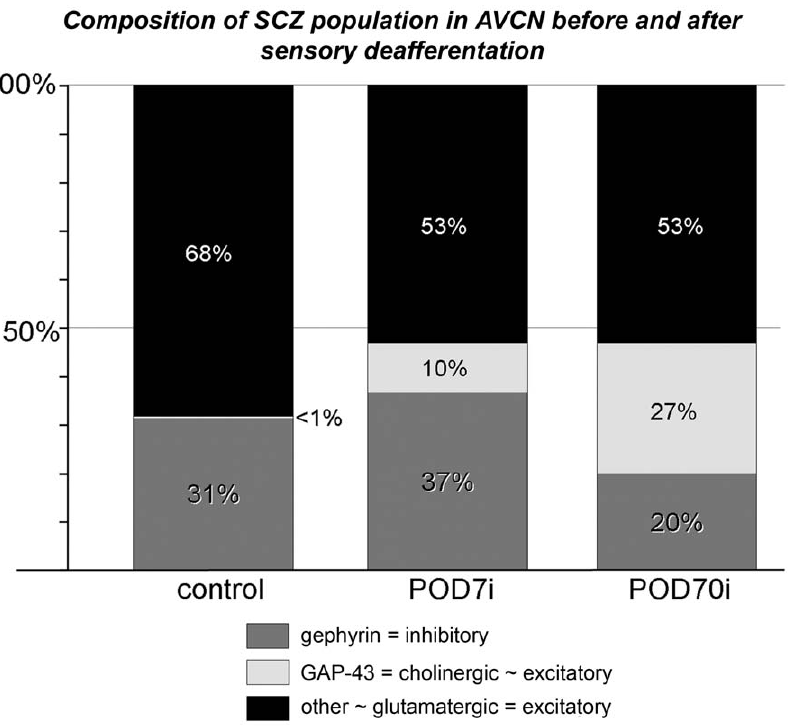
Figure 7. Composition of the population of SCZs in adult controls, by 7 and by 70 days following cochlear ablation. A deafferentation induced reorganization of the neuronal network in AVCN includes a transient rise of inhibitory synapses and the emergence of GAP-43 positive synaptic contacts. After 10 weeks excitatory synaptic contacts have increased in relative number, apparently due to an extended fraction of cholinergic synapses. ‘ , ’ translates to ‘suspected to be’.